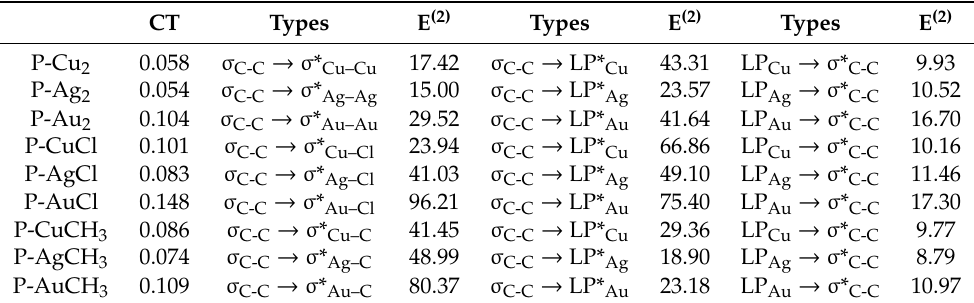
Table 3. Charge transfer (CT, e) and second-order perturbation energies (E (2) , kcal / mol) in the binary